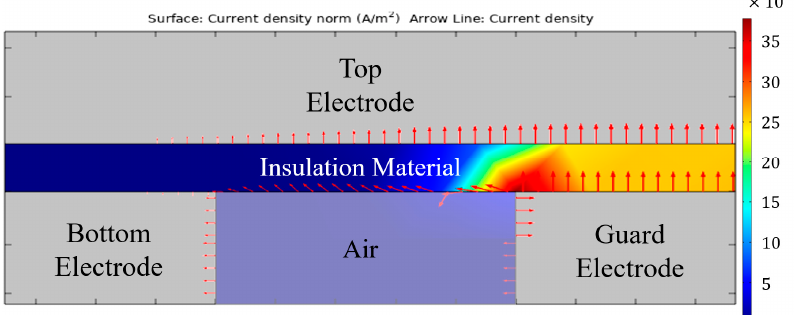
Figure 5. Surface leakage current density and flow.